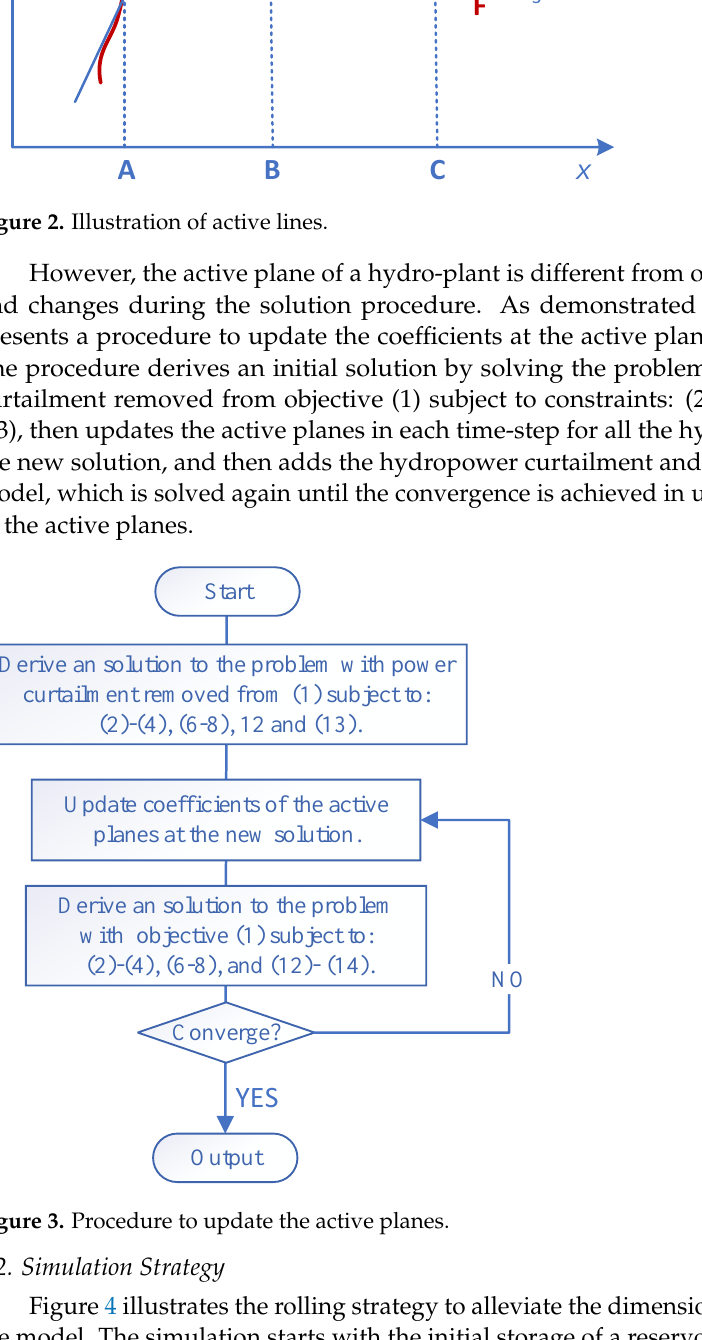
L e t V 2 T / 3 = V T Figure 4. The rolling strategy in simulations over many years. 4. Case Studies The model and methods will be case studied in a river in southwest China involv- ing eleven cascaded hydropower reservoirs. The river and reservoirs are renamed to avoid unnecessary disputes beyond an academic and engineering context.